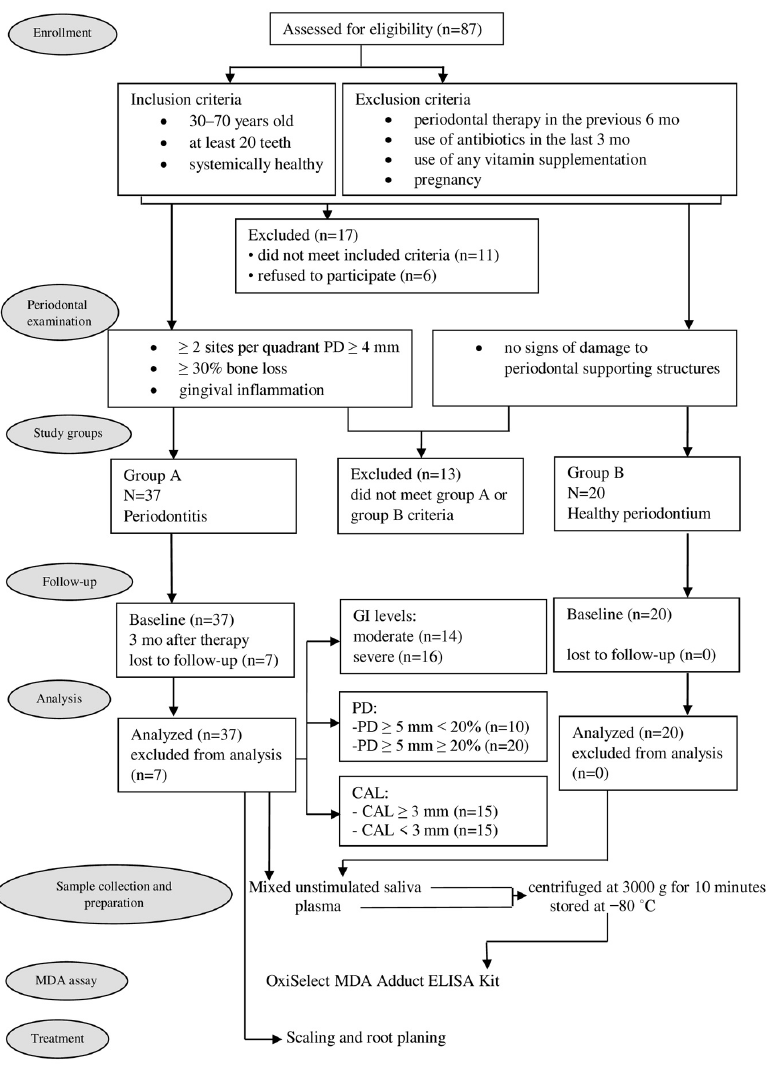
Figure 1. Flow chart of clinical study. GI—gingival index; PD—probing depth; CAL—clinical attachment level;